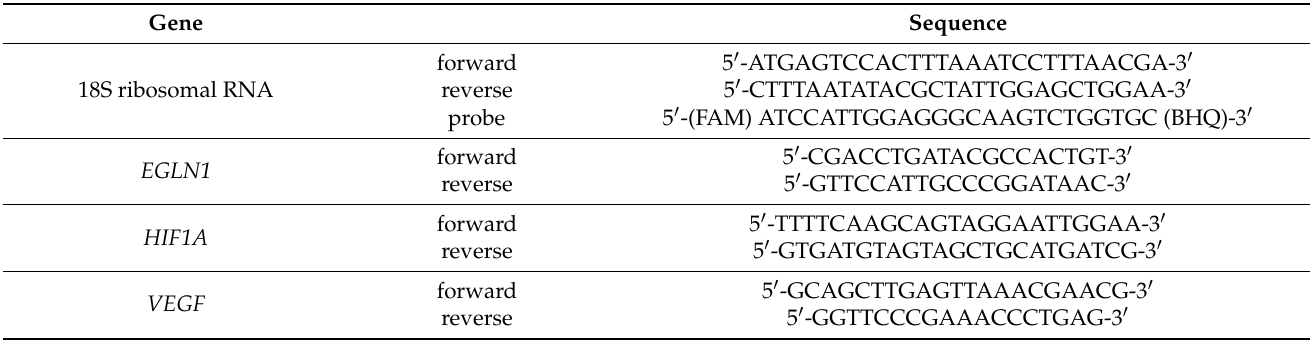
Table 1. The primer sequences for real-time